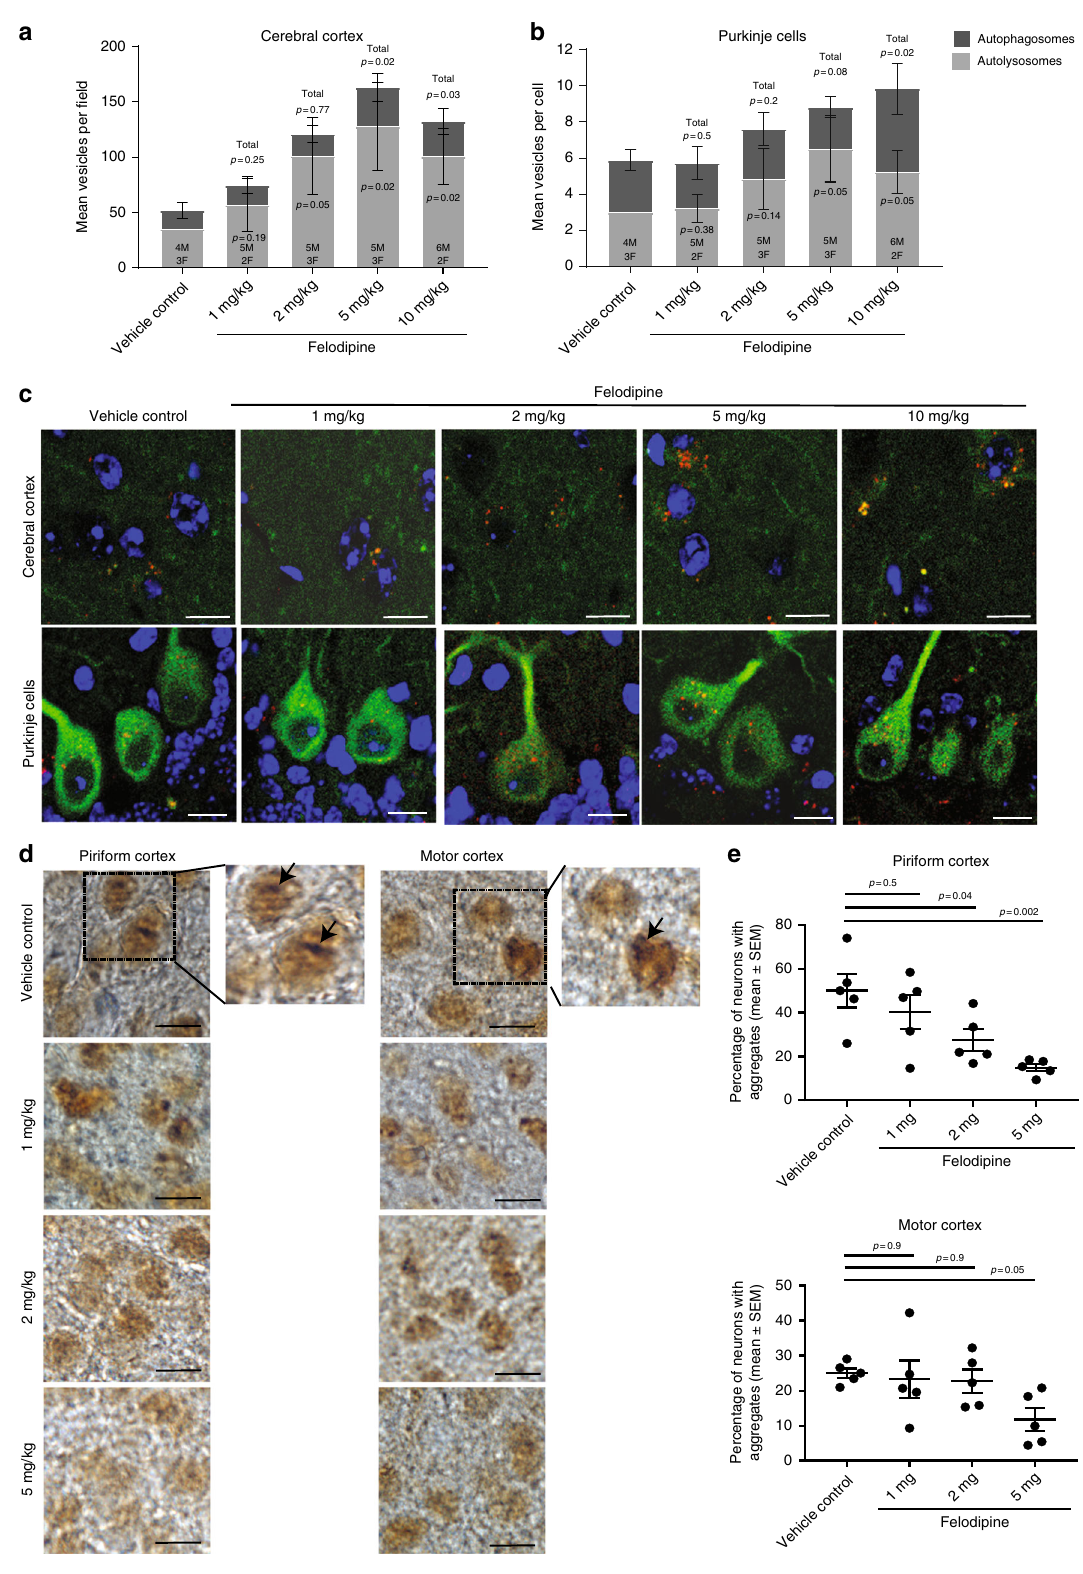
vehicle-treated HD mice (Fig. 3d, Supplementary Table 4). Thus, felodipine improved the motor phenotype in B6HD mice in all the tests we have performed. Felodipine ameliorated the weight loss of the B6HD mice from 19 weeks but had no effects on weight of wild-type mice (Supplementary Fig. 4a, Supplementary Table 5). It was necessary to cull some mice by euthanasia at